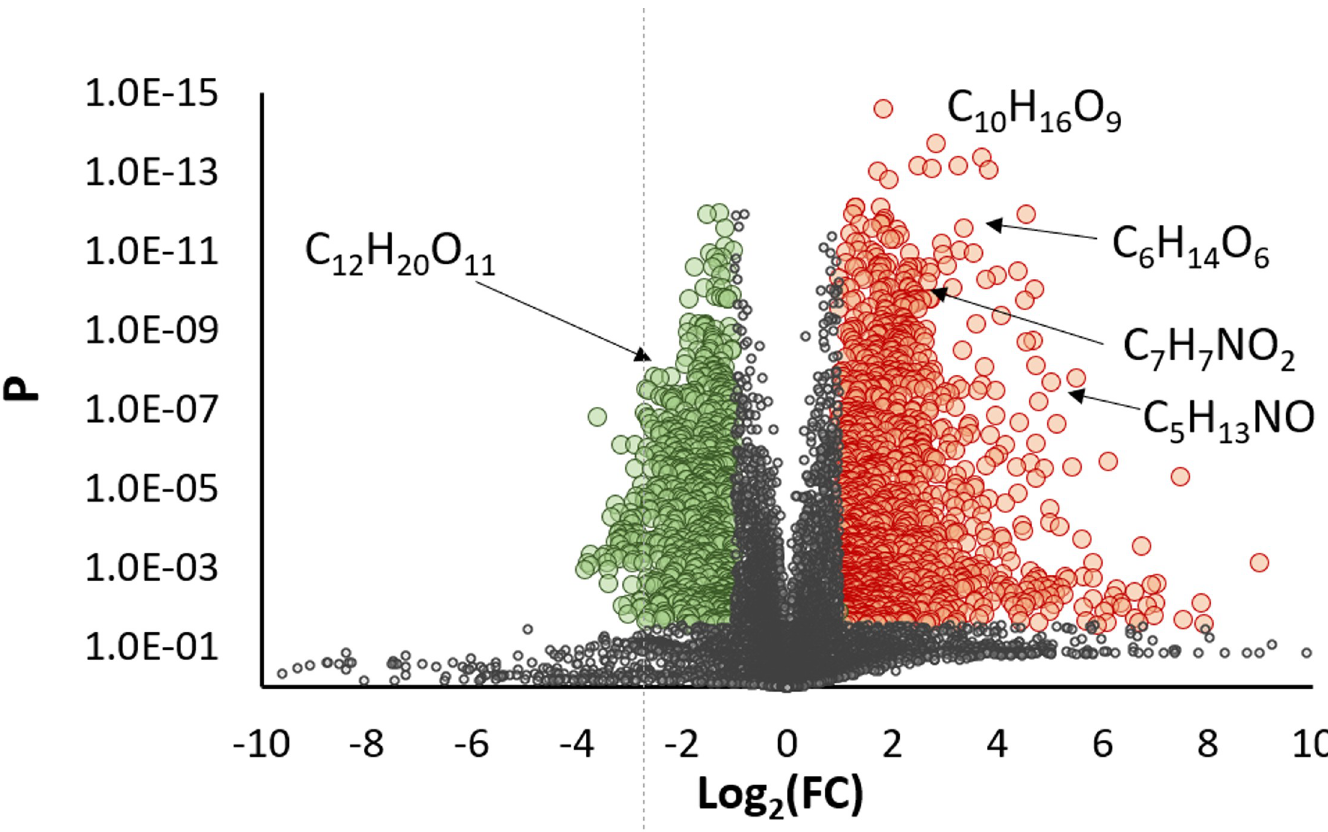
Fig 3. Volcano plot showing differentially present chemical features detected in positive ionization mode. False discovery rate (P) was controlled using the Benjamini-Hochburg procedure. Red circles represent features that are present in significantly increased amounts (P < 0.01; log 2 > 1) in late season sap, while green circles are features that have significantly decreased (P < 0.01; log 2 <